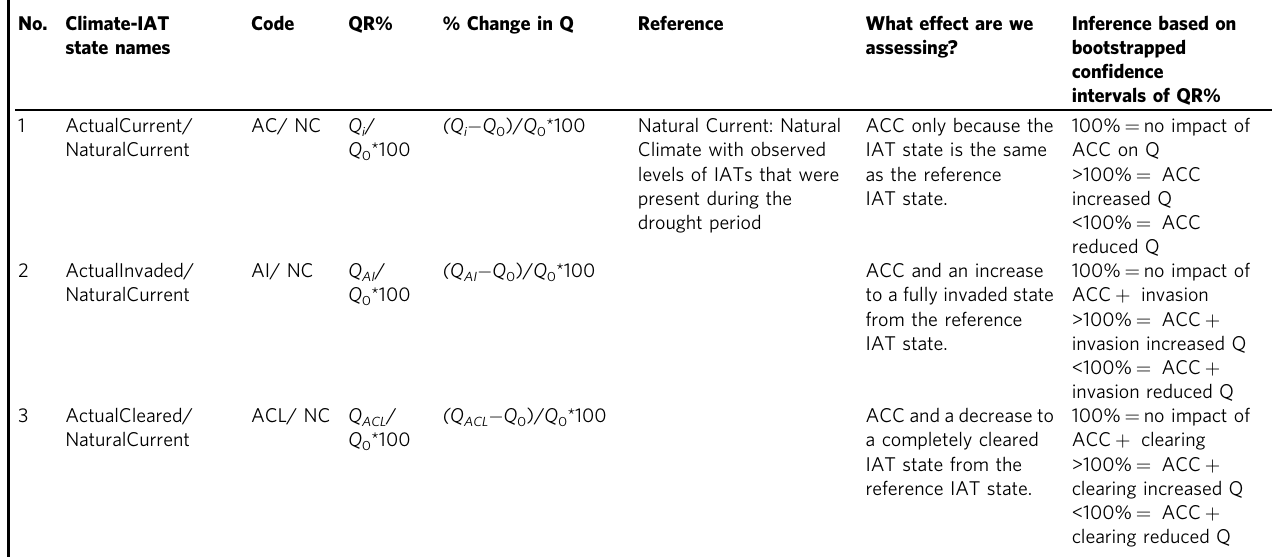
Table 4 Formulae used to calculate the drought-period stream fl ow (Q) ratio (QR), expressed as a percentage (QR%) and the % Change in Q for paired climate-invasive alien tree (climate-IAT) states.